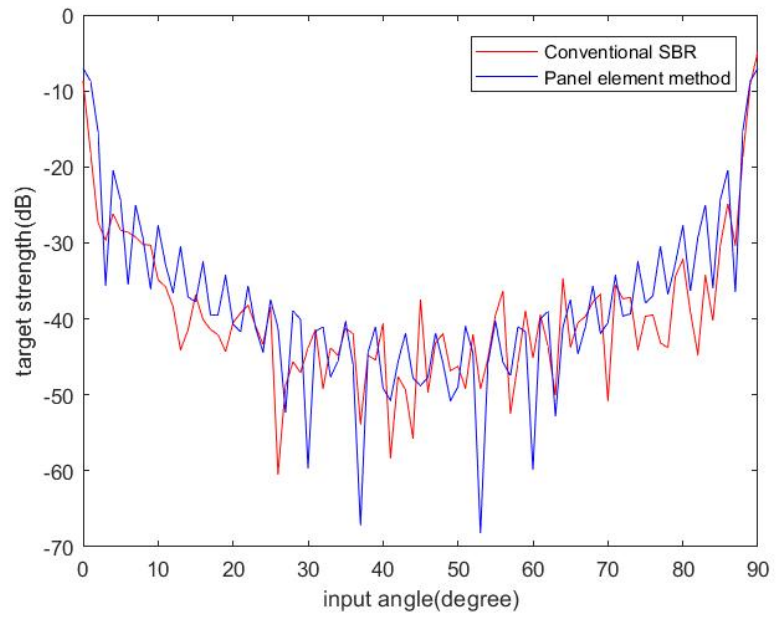
Figure 9. The comparison of our GPU-based SBR result and the PEM result of the corner reflector.